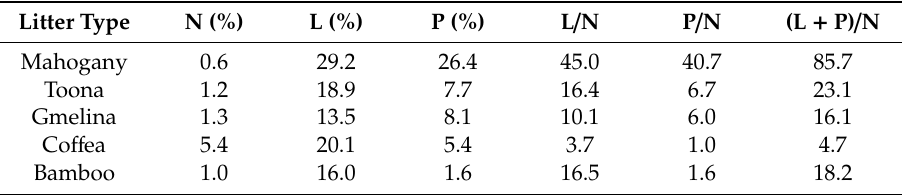
Table 2. Chemical characteristics of tree root system.